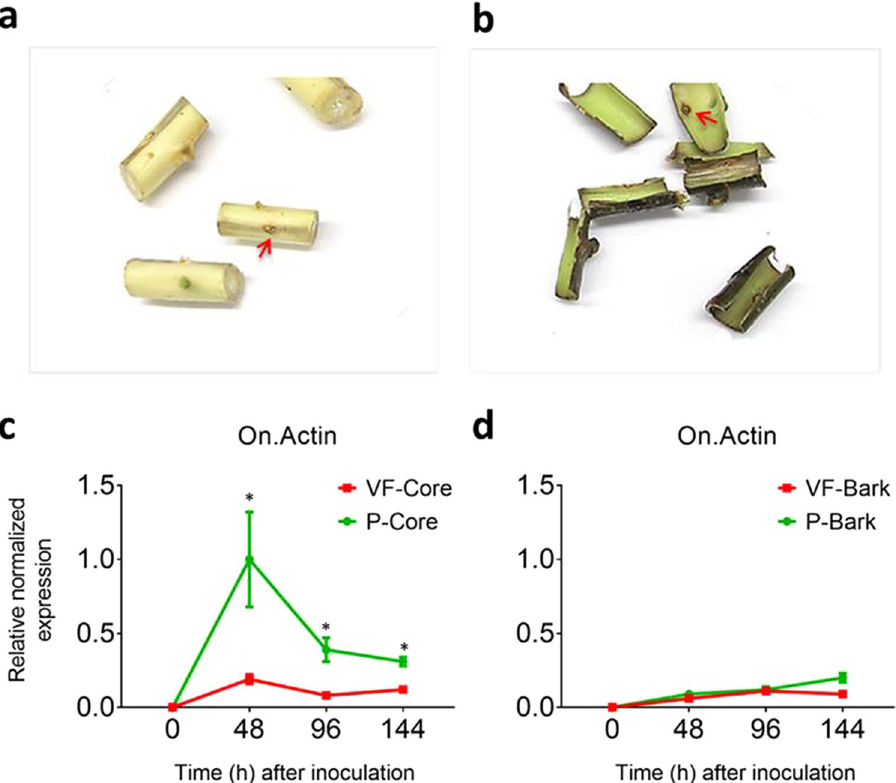
Figure 1. Level of fungal actin transcripts in the inoculated tissues of ‘Valley Forge’ and ‘Princeton’. ( a , b ) Photographs of the core and bark, respectively, of American elm stem sections inoculated with O . novo-ulmi (MH75-4O). Arrows refer to the inoculation point. ( c-d ) Expression of the fungal actin gene ( On-actin ) in mock-inoculated (0 hpi) and inoculated core and bark tissues, respectively, of ‘Valley Forge’ (VF) and ‘Princeton’ (P). The Y-axis shows the expression of On-actin gene normalized to the expression of three elm reference genes ( EIF 5a , vacuolar ATP synthase and splicing factor 3B ) and calculated relative to control (P-core at 48 hpi). Values marked with an asterisk ( * ) are significantly greater ( ≥ 2 times) than the corresponding time point in the other genotype ( P <